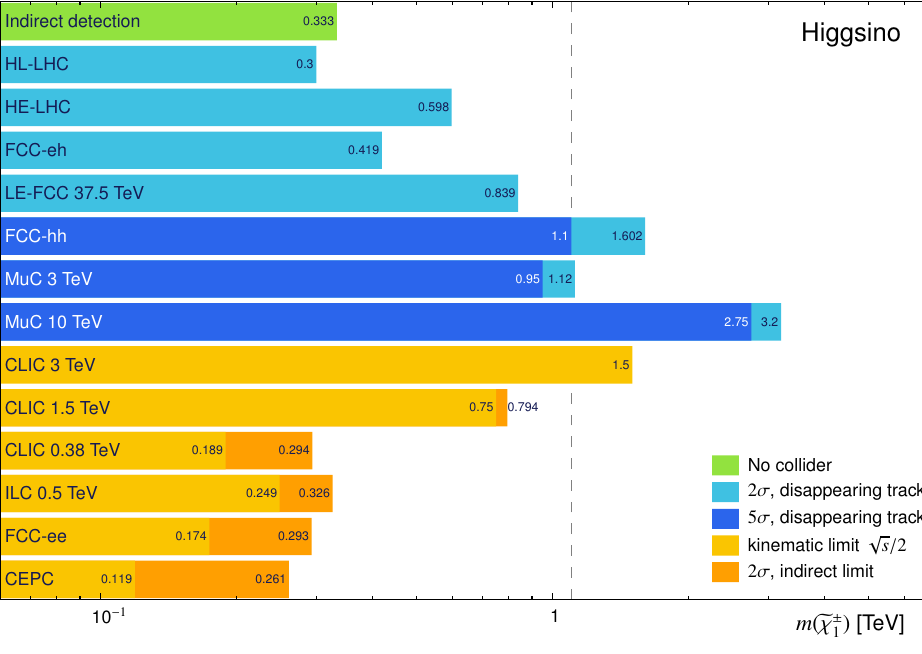
Figure 18. Summary of the sensitivity to pure higgsino models at future experimental facilities. The results for other facilities are taken from refs. [18,